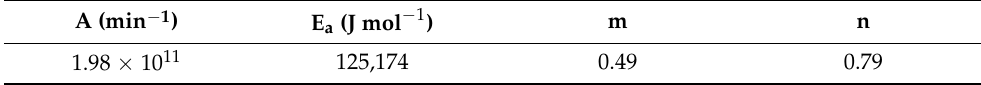
Table 3. Kinetics of the thermal decomposition of PA: first